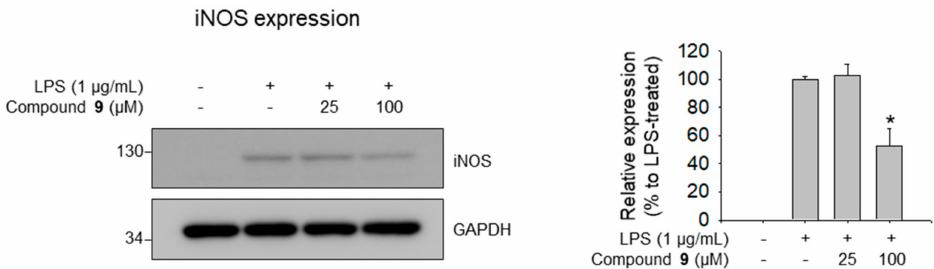
Figure 8. Inhibitory e ff ects of compound 9 on LPS-induced iNOS expression in RAW 264.7 cells. Data represent relative iNOS protein expression levels compared to those in the LPS-treated group (100%). p < 0.05 relative to the LPS-treated control